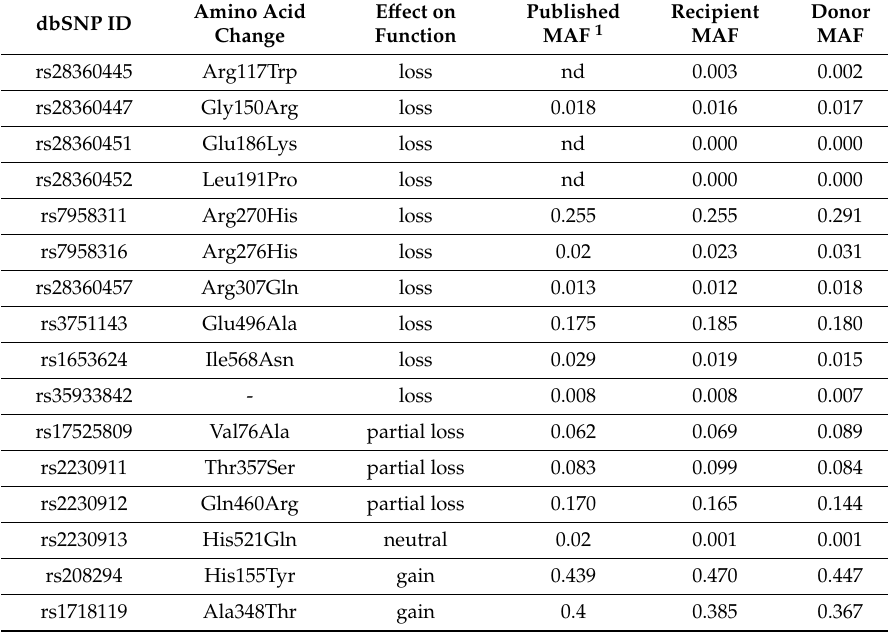
Table 1. P2X7 Single Nucleotide Polymorphism (SNP) Minor Allele Frequency (MAF).